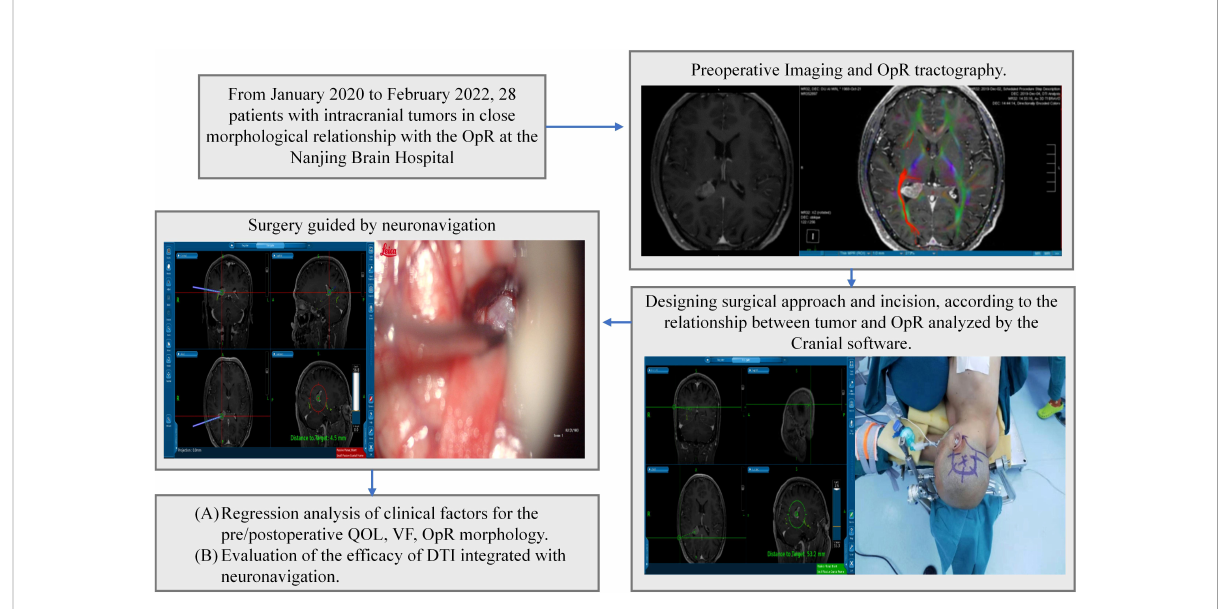
FIGURE 1 Study design. Intraoperative images were acquired following initial dissection and at the end of surgery. OpR, optic radiation, DTI; diffusion tensor imaging, VF; visual function; QOL, quality of